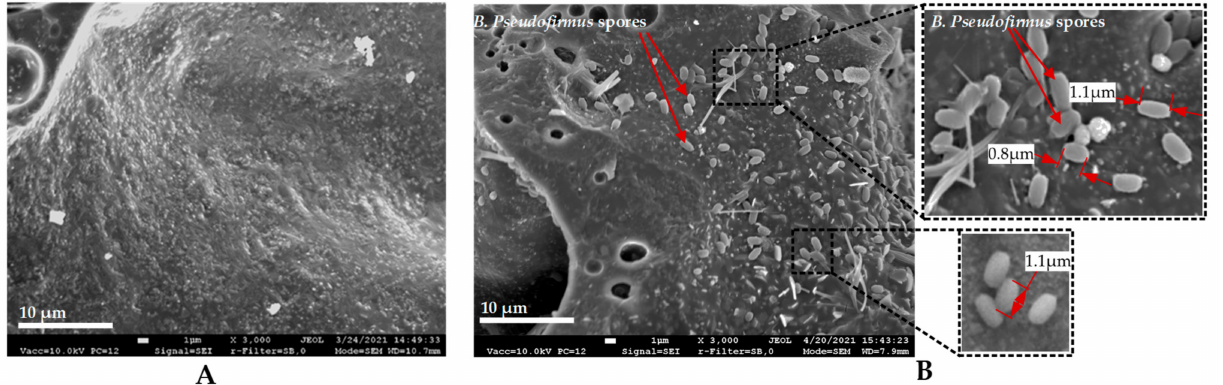
Figure 1. Scanning electron microscopy images of an expanded clay: ( A ) control specimen; ( B ) with immobilized B. pseud- ofirmus